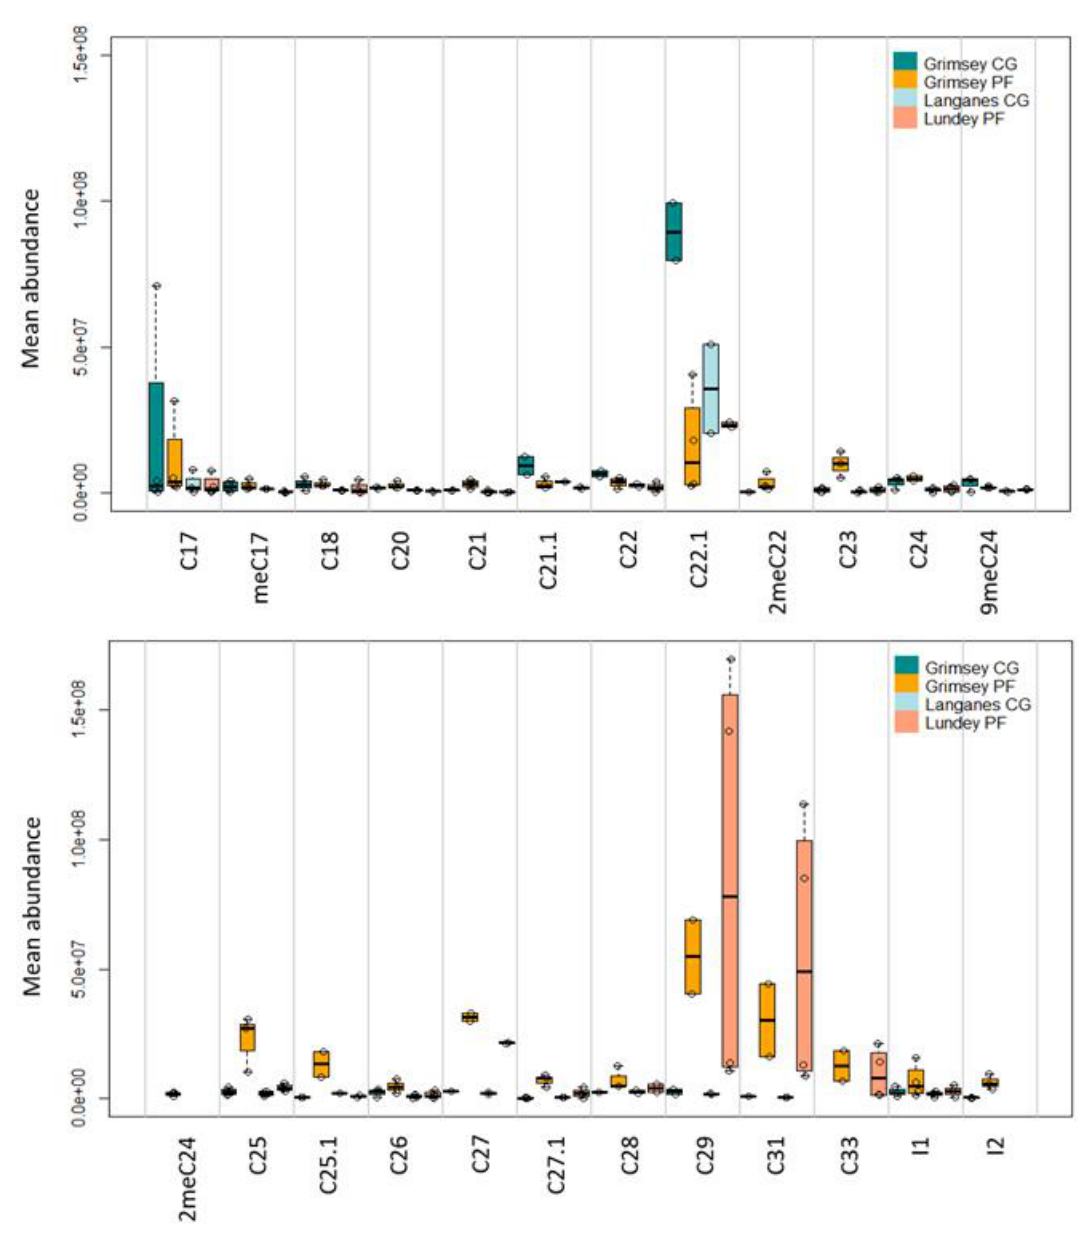
Figure 2 : Boxplot representing the mean abundance of each detected cuticular hydrocarbon from I. uriae ticks. Compounds ranged from 17 to 33 carbon atoms in length. Mean abundance was calculated based on values from four replicate tick pools. First and third quartiles, median and data points are shown. See Table 1 for CHC abbreviations. PF refers to the Atlantic puffin ( Fratercula arctica ) and CG to the Common guillemot ( Uria aalge